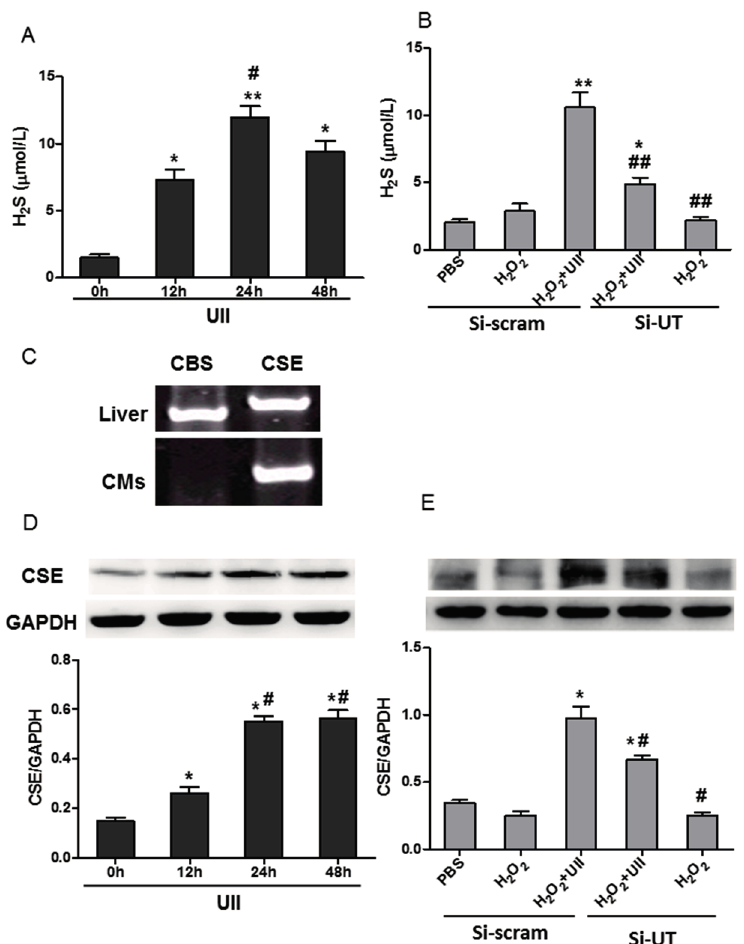
Figure 2. UII increases the production of H 2 S by enhancing the level of CSE in cardiomyocytes exposed to H 2 O 2 . ( A ) H 2 S production was examined in culture supernatant of cardiomyocytes treated with UII at different time points (0, 12, 24, 48 h). Values are mean ± SEM. * p < 0.05, ** p < 0.01 vs. 0 h group; # p < 0.05 vs. 12 h group; ( B ) H 2 S production was examined in culture medium of cardiomyocytes transfected with si-UT or siRNA-scramble for 48 h, then treated with UII (0.1 μ M) or PBS for 30 min and exposed to 100 μ M H 2 O 2 for 24 h. si-UT: Cardiomyocytes (CMs) were transfected with siRNA-UT, or siRNA-scramble as control. Values are mean ± SEM. * p < 0.05, ** p < 0.01 vs. H 2 O 2 group; ## p < 0.01 vs. H 2 O 2 + UII group; ( C ) RT-PCR analysis of CBS and CSE mRNA expression in cultured cardiomyocytes. The expression of CBS and CSE mRNAs in liver tissue was detected as positive control; ( D ) Western blot analysis of CSE level in cardiomyocytes treated with UII at different time points (0, 12, 24, 48 h). Values are mean ± SEM. * p < 0.05 vs. 0 h group; # p < 0.05 vs. 12 h group; ( E ) Western blot analysis of CSE level in cardiomyocytes transfected with si-UT or siRNA-scramble for 48 h, then treated with UII (0.1 μ M) or PBS for 30 min and exposed to 100 μ M H 2 O 2 for 24 h. CMs: Cardiomyocytes. Si-UT: CMs were transfected with siRNA-UT; Si-scram: CMs were transfected with siRNA-scramble as control. Values are mean ± SEM. * p < 0.05 vs. H 2 O 2 group; # p < 0.05 vs. H 2 O 2 + UII group. All experiments were repeated independently at least three